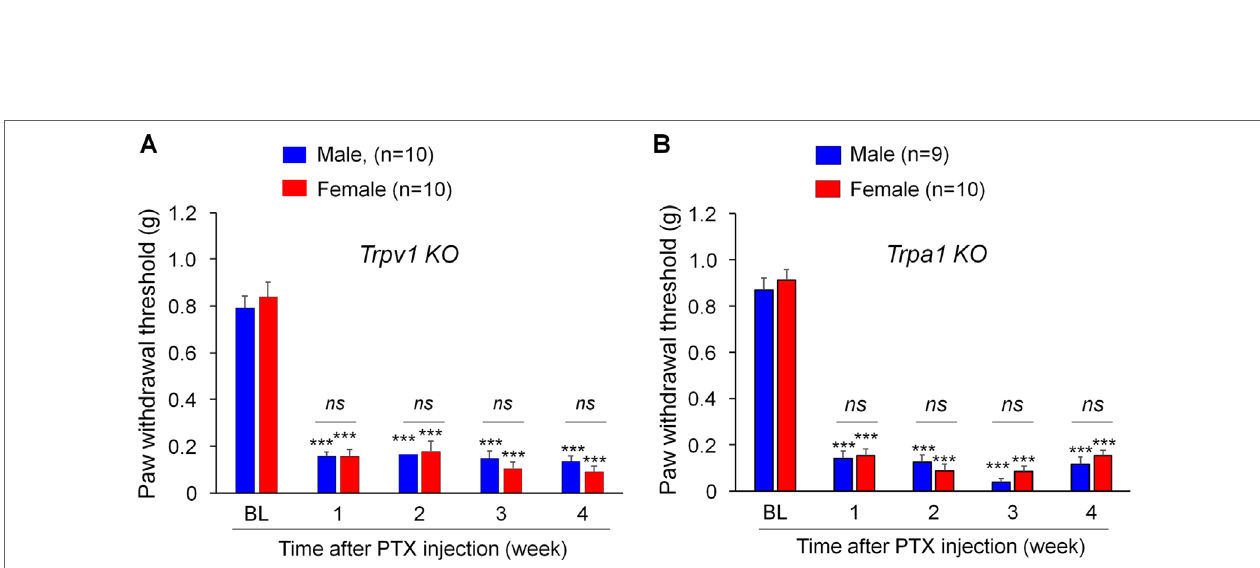
FIGURE 1 | Effects of intrathecal RvD1-D5 on mechanical allodynia in male mice (A) and female mice (B) 2 weeks after paclitaxel (PTX) injection. Intrathecal RvD1 and RvD2 (100 ng) reduced mechanical allodynia in both sexes. However, intrathecal RvD5 only reduced mechanical allodynia in male mice. ***p < 0.001 versus the vehicle group. Two-Way ANOVA with Bonferroni’s post-hoc test, n = 6-8 mice per sex per group.